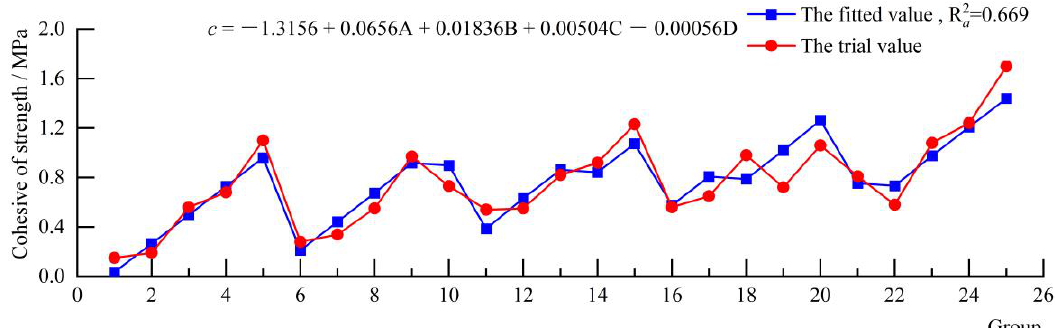
Figure 7. Comparison of fitted and experimental results for cohesion.